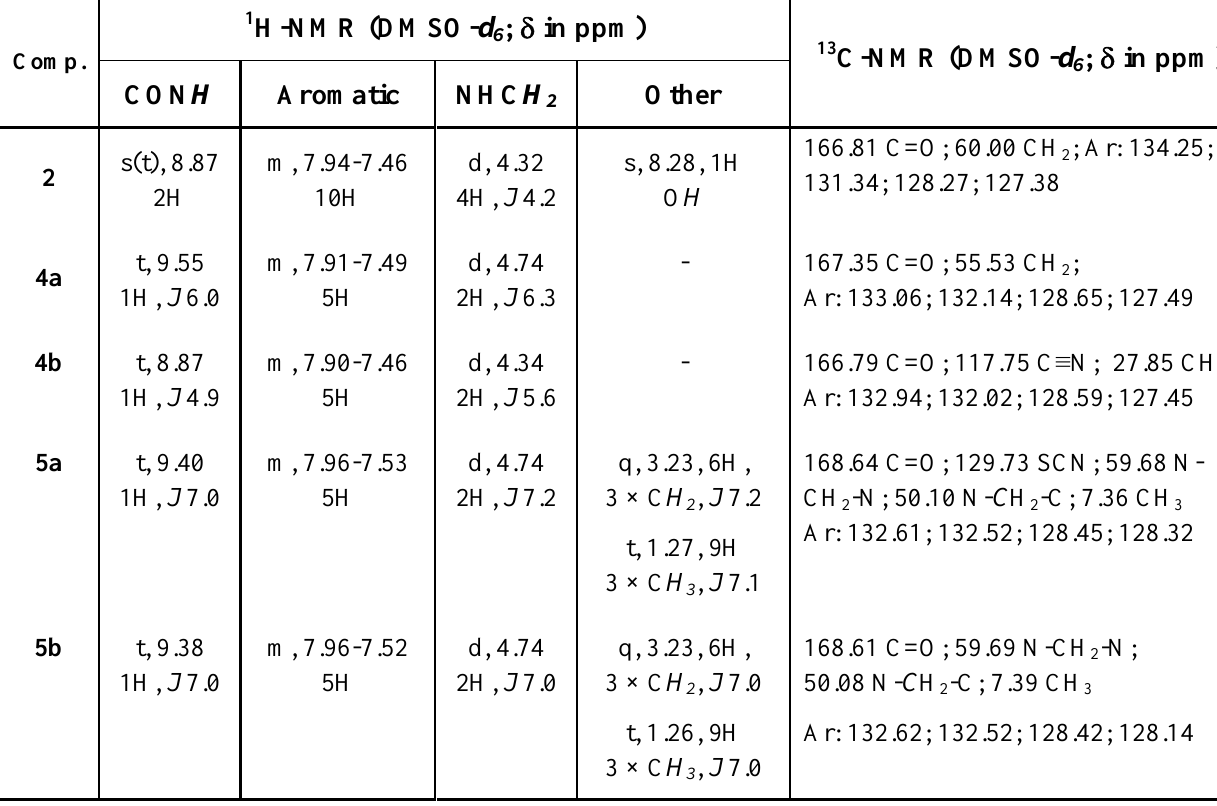
Table 2. NMR data for compounds 2-5b